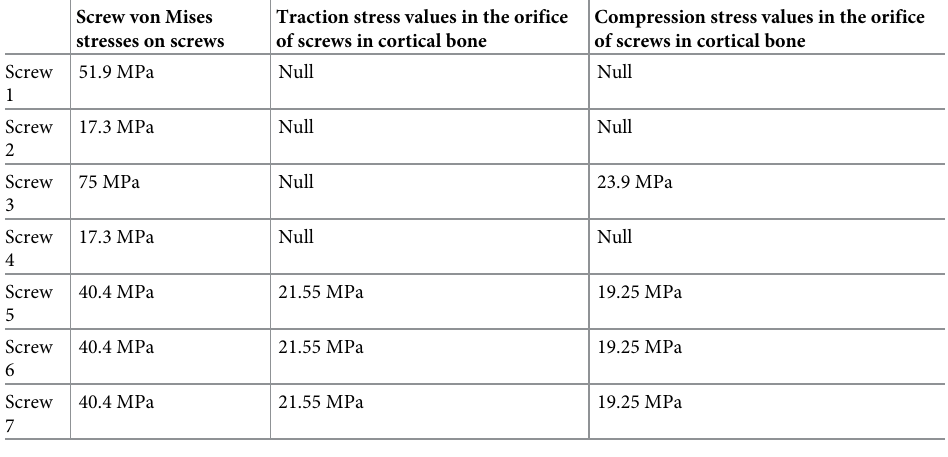
Table 2. Values of Von Mises stress in the screws.